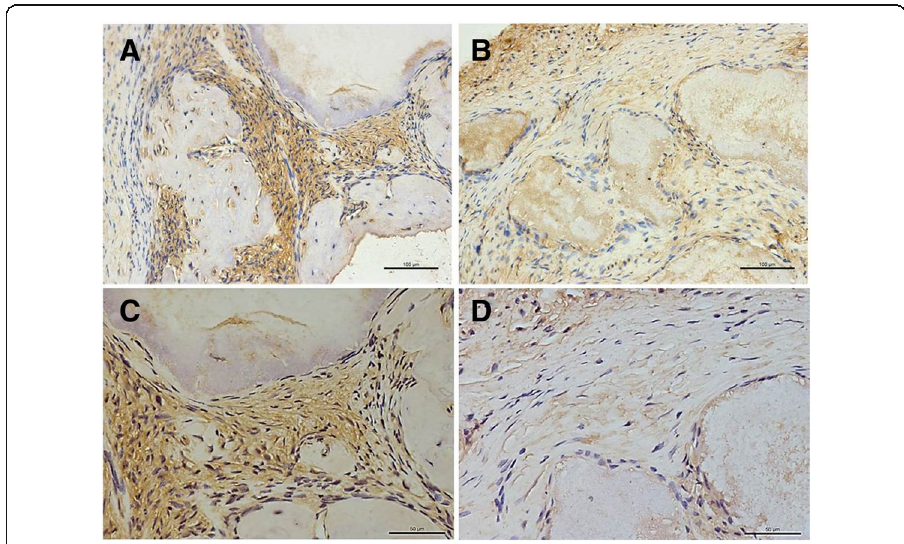
Fig. 3 SFRP2 enhanced the phosphorylation of β -catenin in vivo. Immunohistochemical analysis showed that the overexpression of SCAP-SFRP2 increased the phosphorylation of β -catenin ( a , c ), SCAP-vector was used as the control ( b , d ). Scale bars = 100 μ M ( a , b ) and 50 μ M ( c , d )